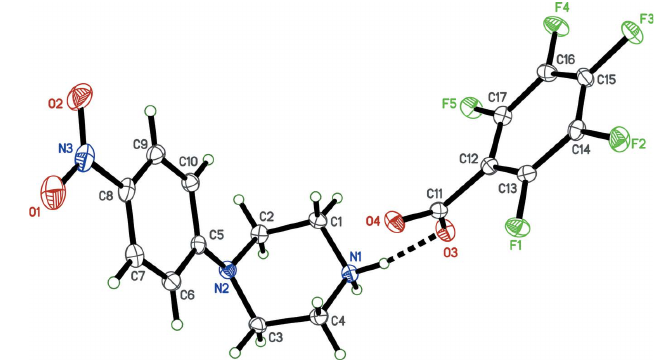
Figure 1 The molecular structure (50% displacement ellipsoids) of I . Hydrogen atoms are shown as arbitrary circles. The dashed line indicates a hydrogen bond.